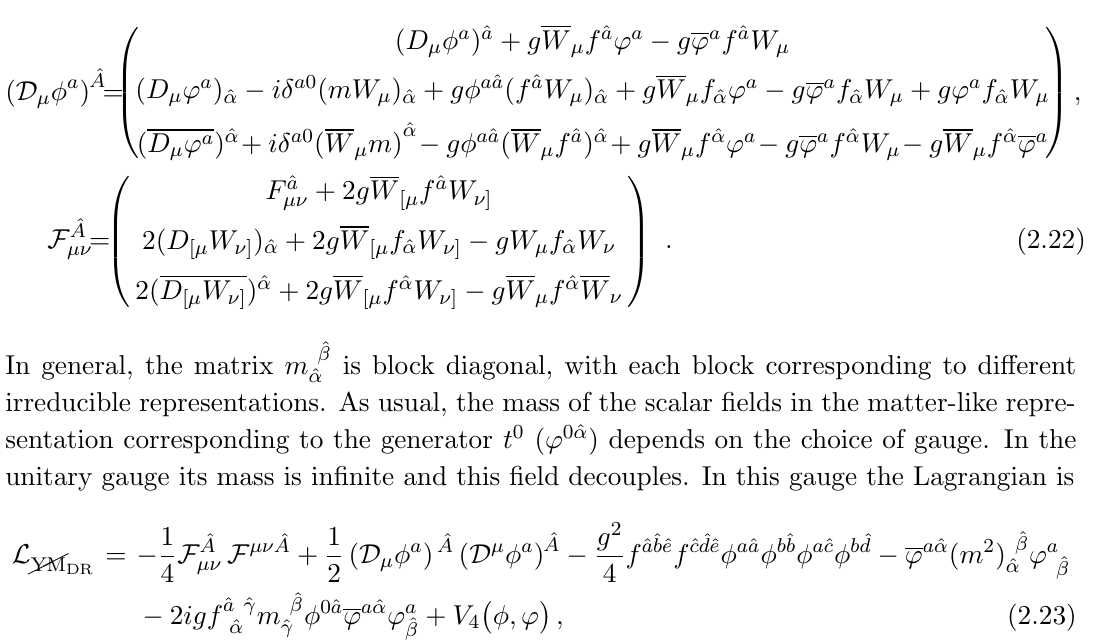
Figure 4 . Pictorial representation of additional color Lie-algebra relations that are obtained after the gauge symmetry spontaneously-broken in a purely adjoint theory. These are also pictorial representations of the kinematic algebra that should be imposed on diagram numerators in the context of color/kinematics duality. The relations are generalizations of the Jacobi identity. Curly lines represent unbroken adjoint states (massless (cid:12)elds) and double lines represent broken non- hermitian states (massive (cid:12)elds). Solid fat lines in (d) represent sums over all three types of states (the massless and two conjugates of the massive ones), giving seven terms in the (d) identity. representations of the unbroken part of the gauge group leads to 11